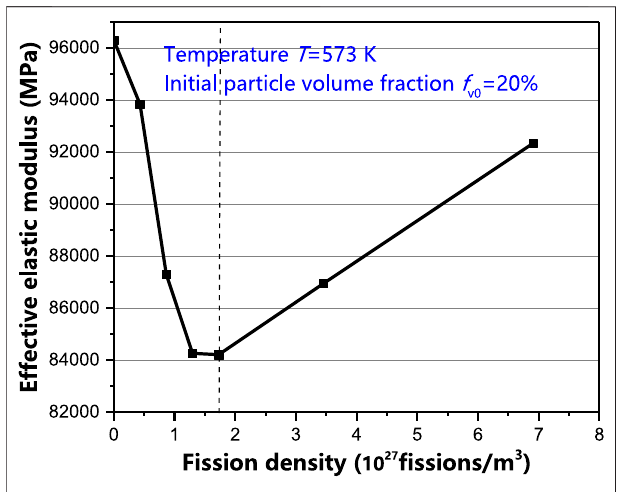
FIGURE 7 | Postirradiation effective elastic modulus as a function of particle fi ssion